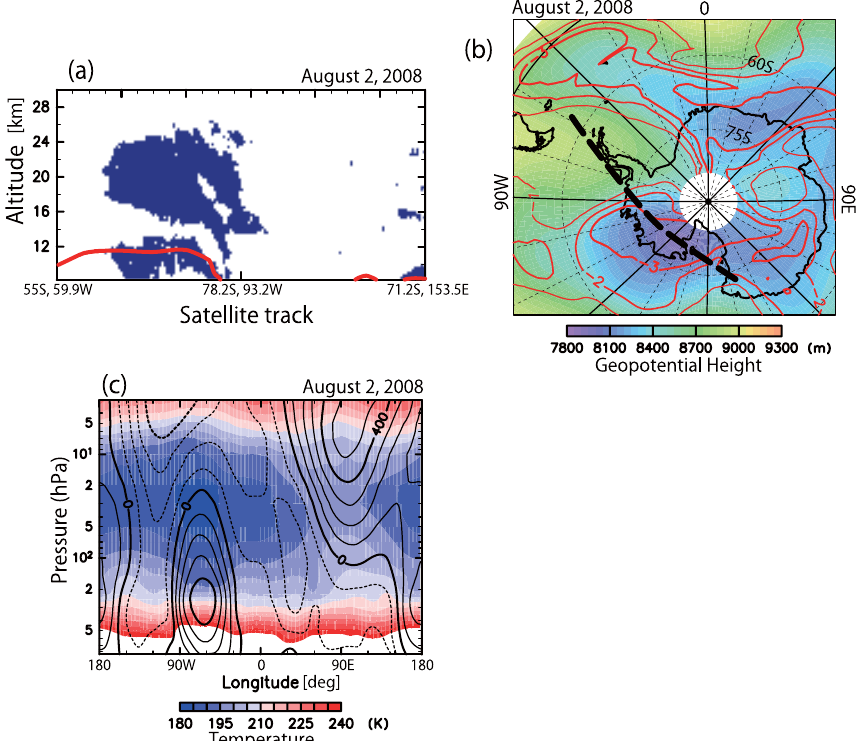
Fig. 8. (a) A horizontal and height section of the location of PSC/UC flags (blue color) along the CALIPSO orbit on 2 August 2008. The red curve indicates the tropopause heights. (b) A polar stereo projection map of geopotential heights (in color; unit is m) at 300hPa and PV (red contour; unit is PVU) on a 300K isentropic surface. Contour interval is 1PVU. The broken thick curve indicates the satellite track in (a) . (c) A longitude and pressure section of geopotential height anomalies from the zonal mean (contours; unit is m) and temperatures (in color; unit is K) at 65 ◦ S. Contour interval is 100m. Broken contours indicate negative